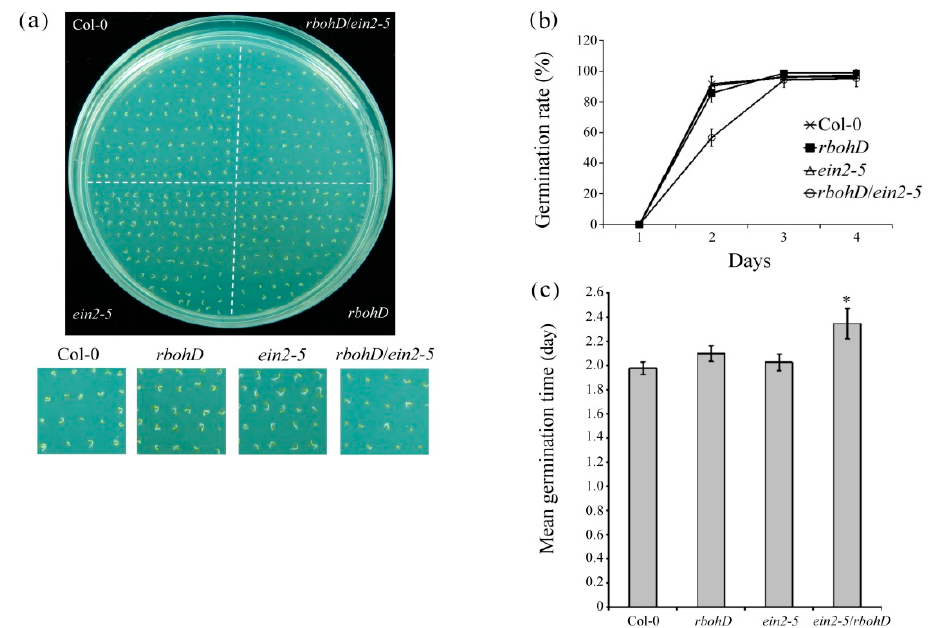
Figure 2. Germination assay of wild-type, rbohD , ein2-5 and rbohD / ein2-5 mutants. ( a ) Germination of wild-type, rbohD and ein2-5 single mutants, and double mutant rbohD / ein2-5 seeds. Seeds were sown in 1 / 2 MS medium and grown for 3 d at 4 ◦ C in dark conditions; photographs were taken after 2 d. ( b , c ) Germination rates and mean germination times of wild-type, rbohD and ein2-5 single mutants, and double mutant rbohD / ein2-5 seeds. Seeds were scored for 1, 2, 3, and 4 d after sowing from at least 100 seeds of each genotype with three replicates each. Error bars represent SD. * p < 0.05, versus wild-type (Student’s t